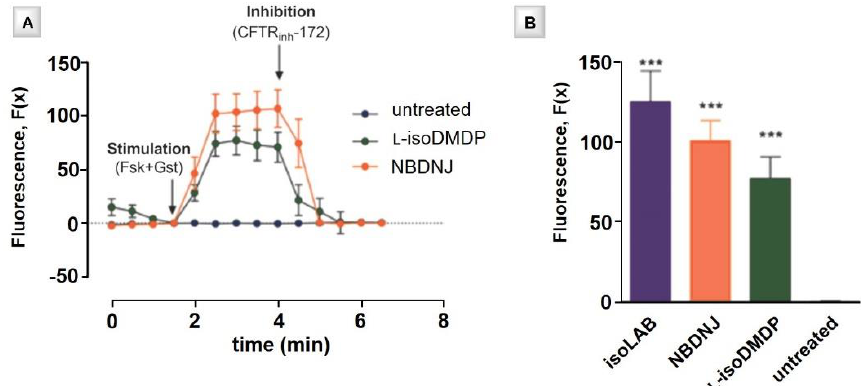
Figure 12. Effect of L -isoDMDP, isoLAB and NBDNJ on the activity of F508del-CFTR in human airway epithelial CF-KM4 cell line, assessed by single-cell fluorescence imaging. ( A ) Cells were incubated with the iminosugars (100 μM, 4 h) in the presence of forskolin/genistein, followed by inhibition with CFTR inh -172. ( B ) Histograms summarizing the results collected from separate experiments. *** p < 0.001. This figure is adapted with permission from [139]. Copyright (2013) American Chemical Society.